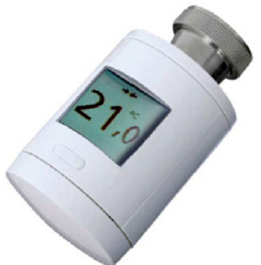
Figure 2. Smart thermostatic valves: HORA SmartDrive Mx. The smart thermostatic valves (STVs) allow users to set their desired setpoint temperature, which is displayed on the screen. The setpoint range is 10 to 30 °C. Valve aperture is regulated by the setpoint and the room temperature. Room temperature is detected by an integrated temperature sensor and corrected for temperature influences by an algorithm.